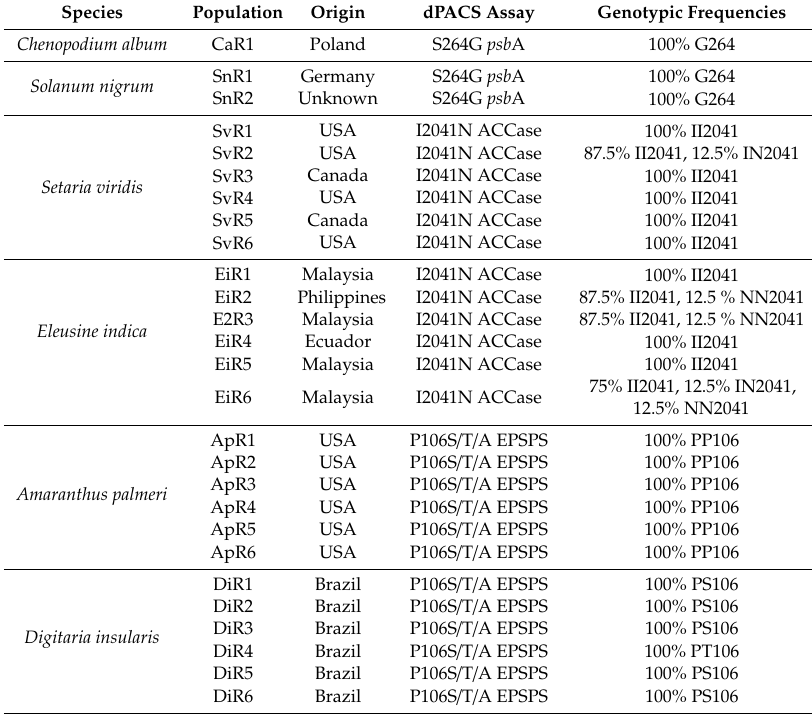
Table 2. Genotypic frequencies of wild and mutant psb A, acetyl-CoA carboxylase (ACCase)